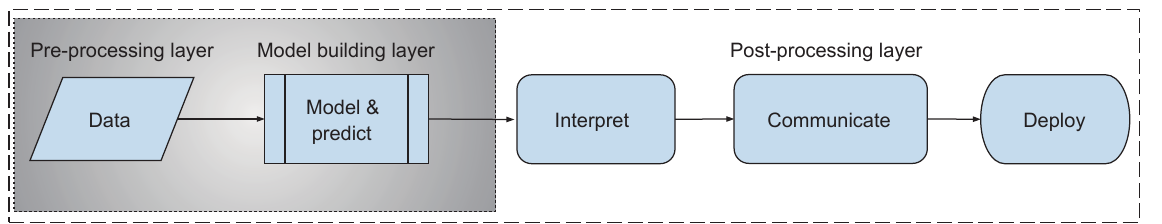
Fig. 1 A reduced model of a DSL. The pre-processing and model building layers operate within a black box from the perspective of the constituent/stakeholder, while the post-processing layer operates openly from the perspective of the constituent/stakeholder.